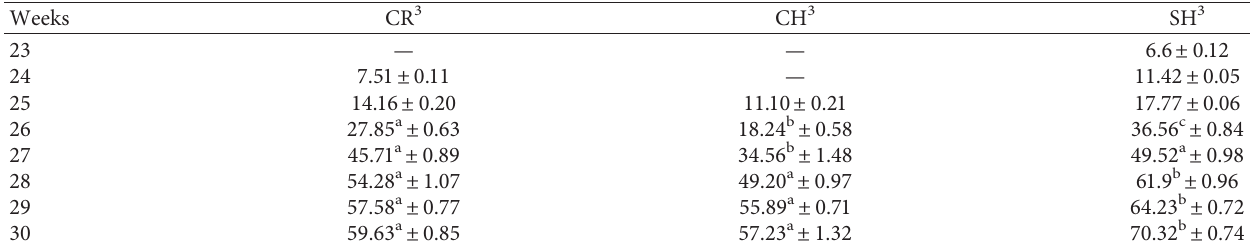
Table 6: Effect of different treatments during exposure 1 on the production of eggs (percentage) of Nicobari chickens during the post- exposure period (laying period) 2 .